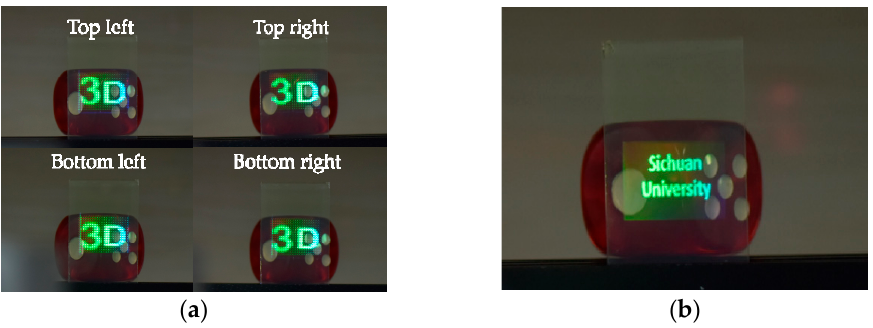
“dice” behind the MHOE is always visible on both 2D and 3D display modes, which good optical see-through properties of the system. verifies the good optical see-through properties of the system.